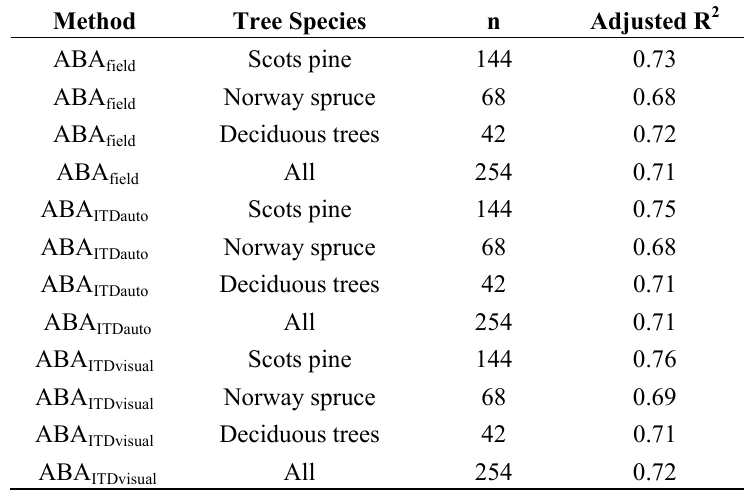
Table 6. Adjusted R 2 for ABA methods in AGB imputations compared with test set.